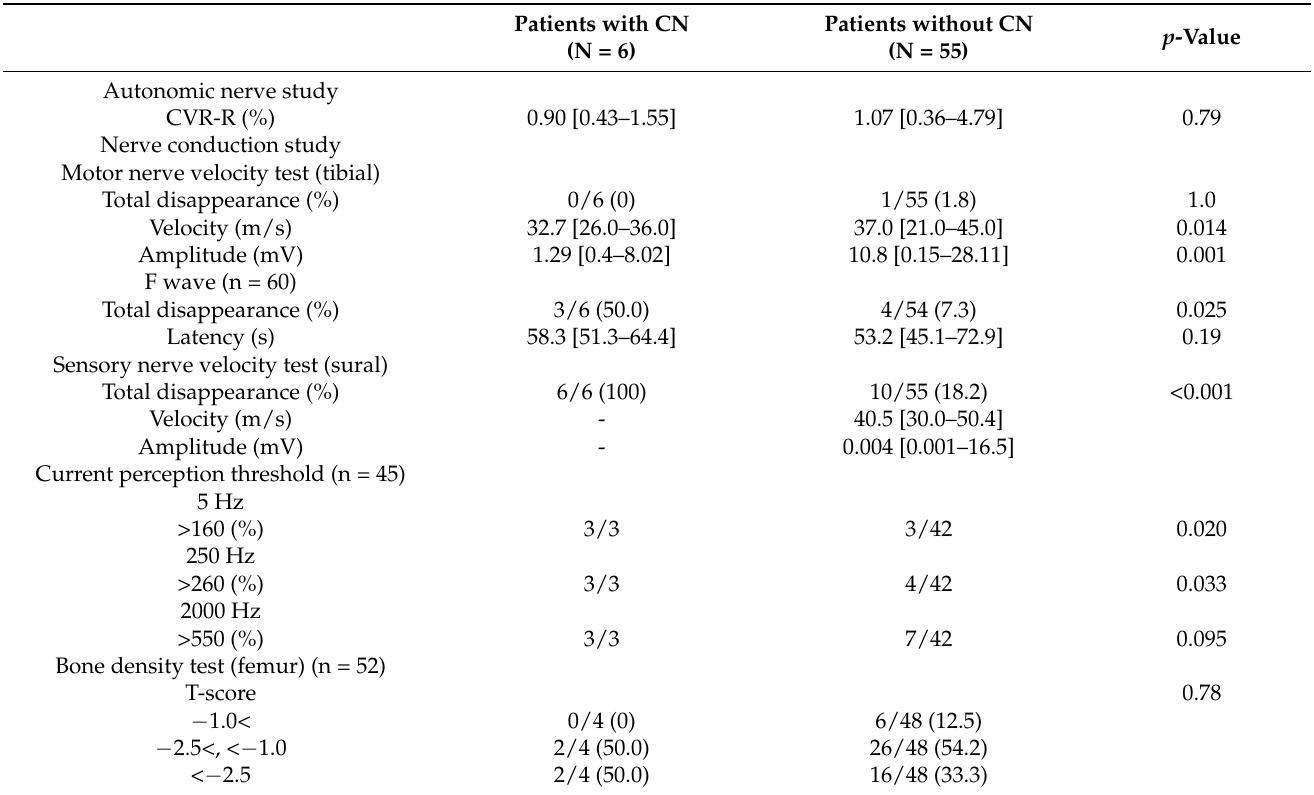
Table 2. Neurological examination